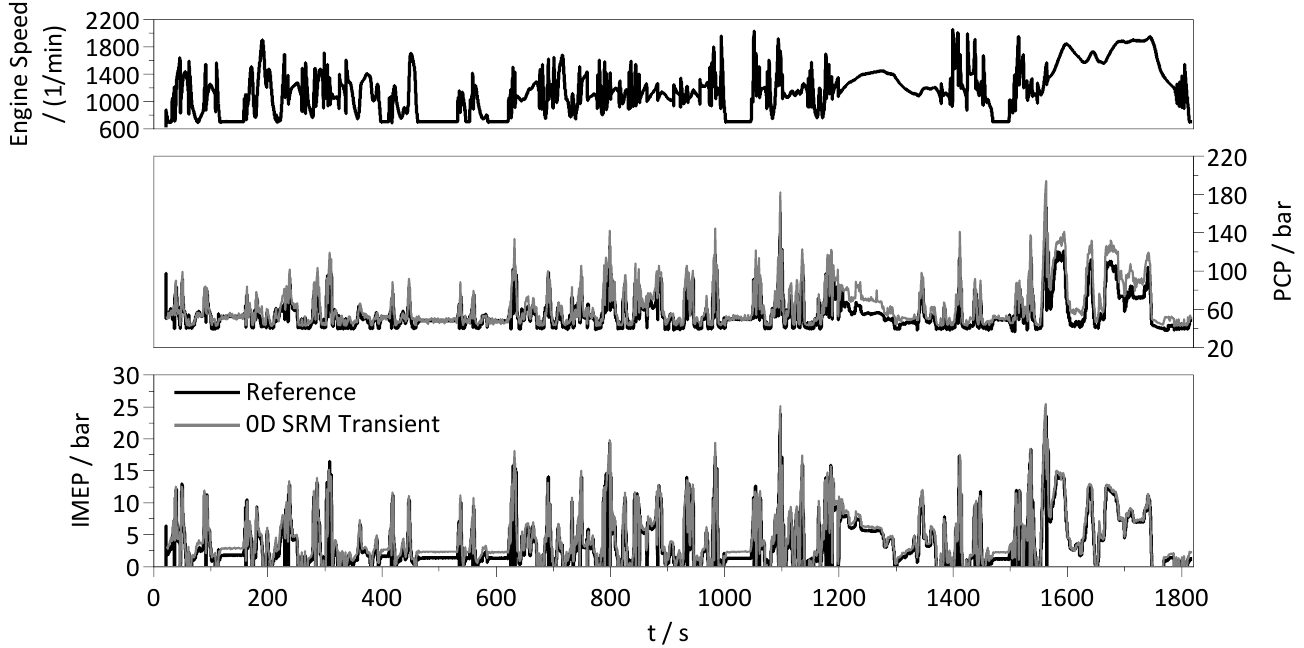
Figure 7. Verification of the 0D SRM compared to reference measurements. The absence of an idle controller in the simulation of the detailed model used to generate the reference IMEP and PCP affected the offset observed in the idling phases. Deviations in the PCP can be observed at around 1250 and 1700 s. A zoomed section of the WLTC (Figure 8) highlights the reference valve position and the delta pressure through the LP-EGR valve. In particular, at high speed and loads, the simulated back pressure is lower than in the real vehicle measurements. Consequently, the simulated PCP is higher since the EGR rate is increased. This is the cause for the PCP deviation.